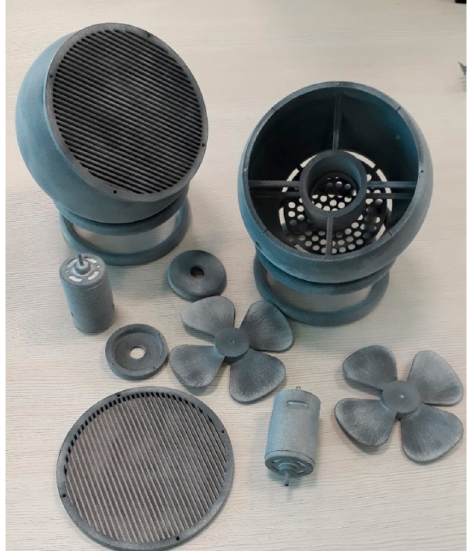
Figure 21. Final result achieved.